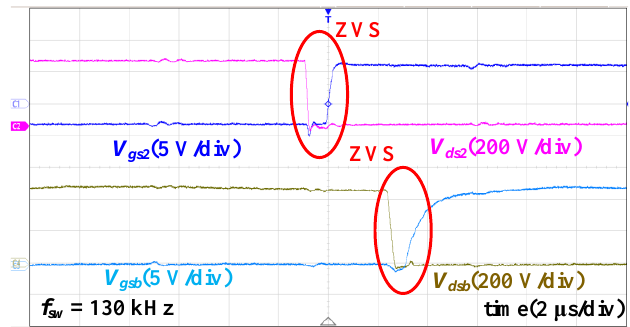
Figure 19. Waveforms of ZVS.